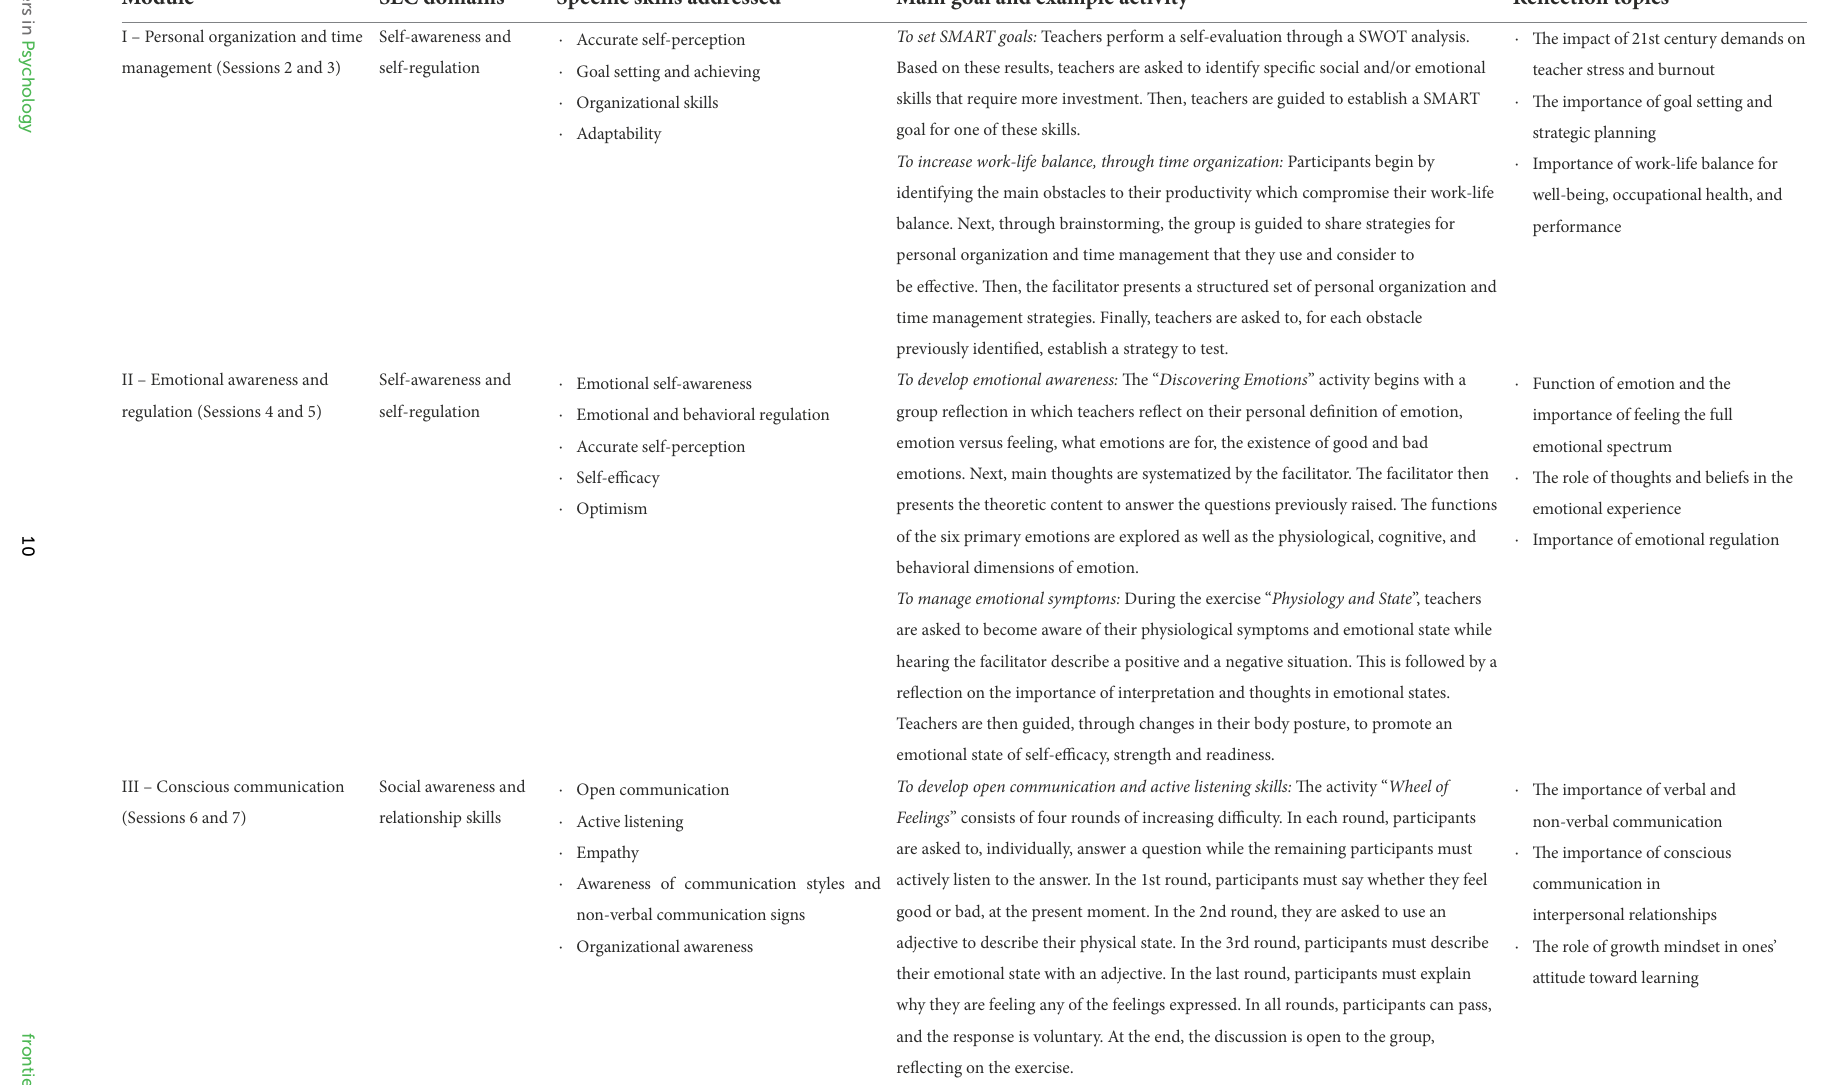
TABLE 2 Structure and contents of the A + intervention